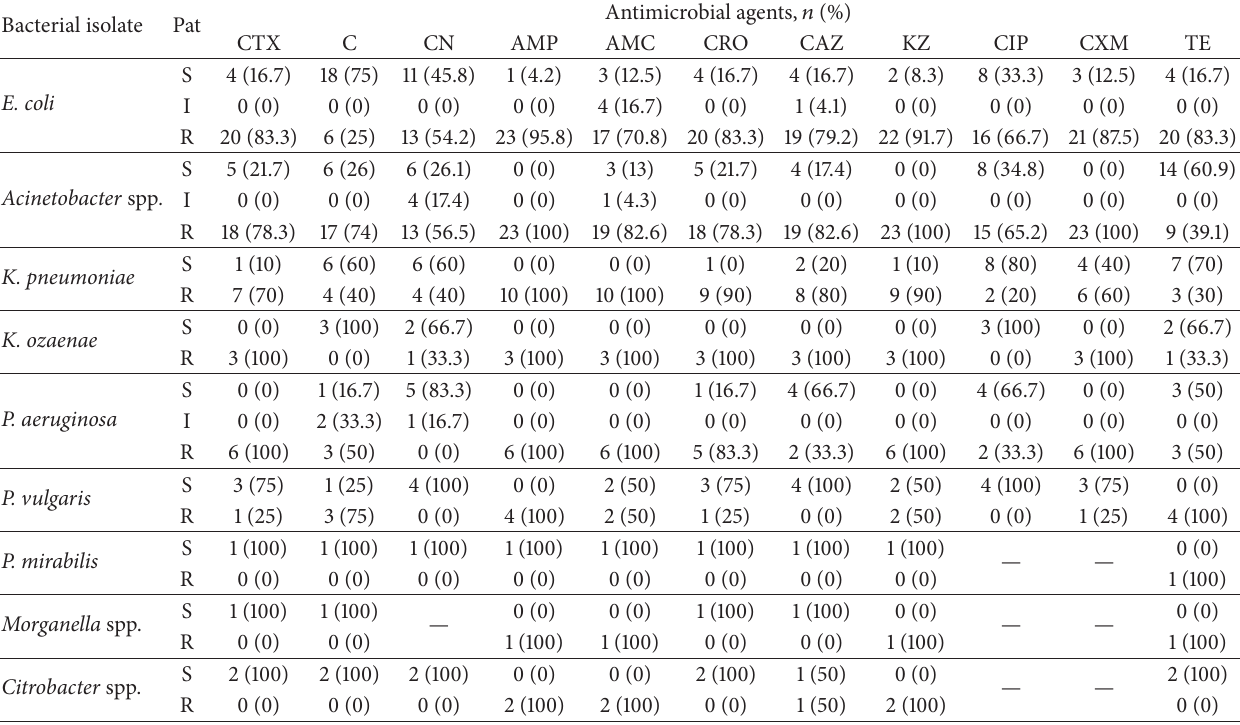
Table 5: Antibiotic susceptibility pattern of Gram negative bacterial isolates in postoperative surgical site infected patients in selected referral hospitals of Addis Ababa.